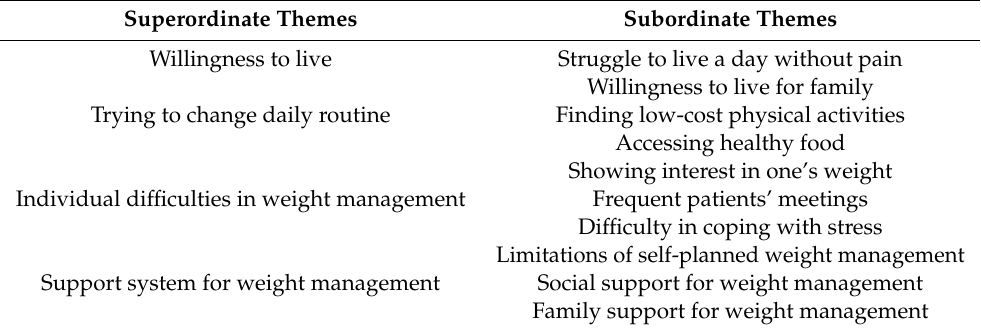
Table 2. Superordinate and subordinate themes of weight management experiences of breast cancer patients treated with